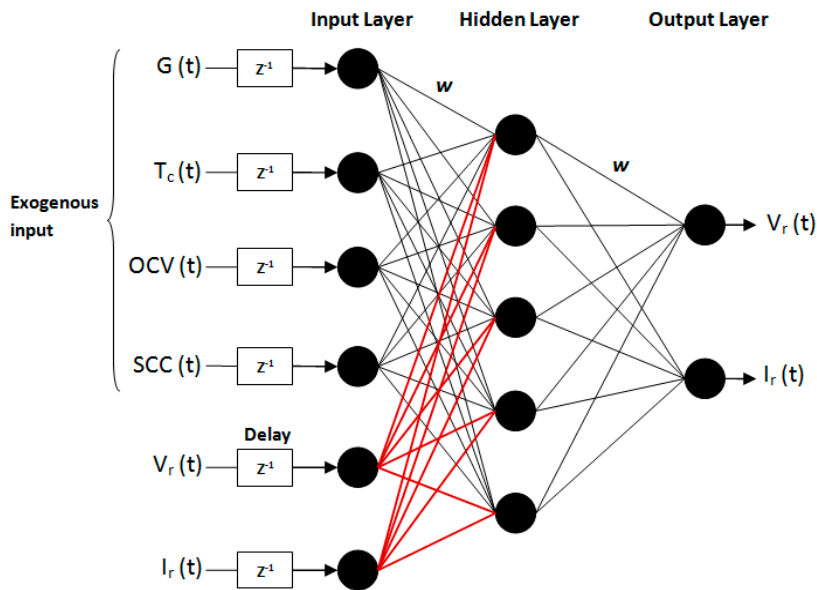
Figure 4. The developed NARX network topology.